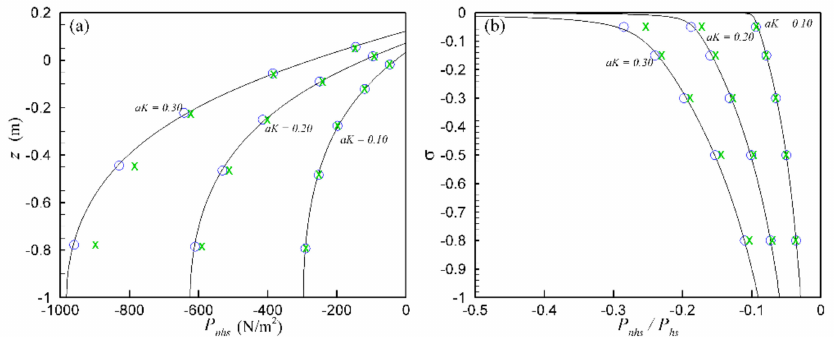
Figure 6. ( a ) The vertical distribution of non-hydrostatic pressure and ( b ) the relative ratio between non-hydrostatic pressure and hydrostatic pressure under wave crest for non-linear deep-water waves: analytical solution (solid lines), FNHS mode (circles), and QNHS mode (X marks).